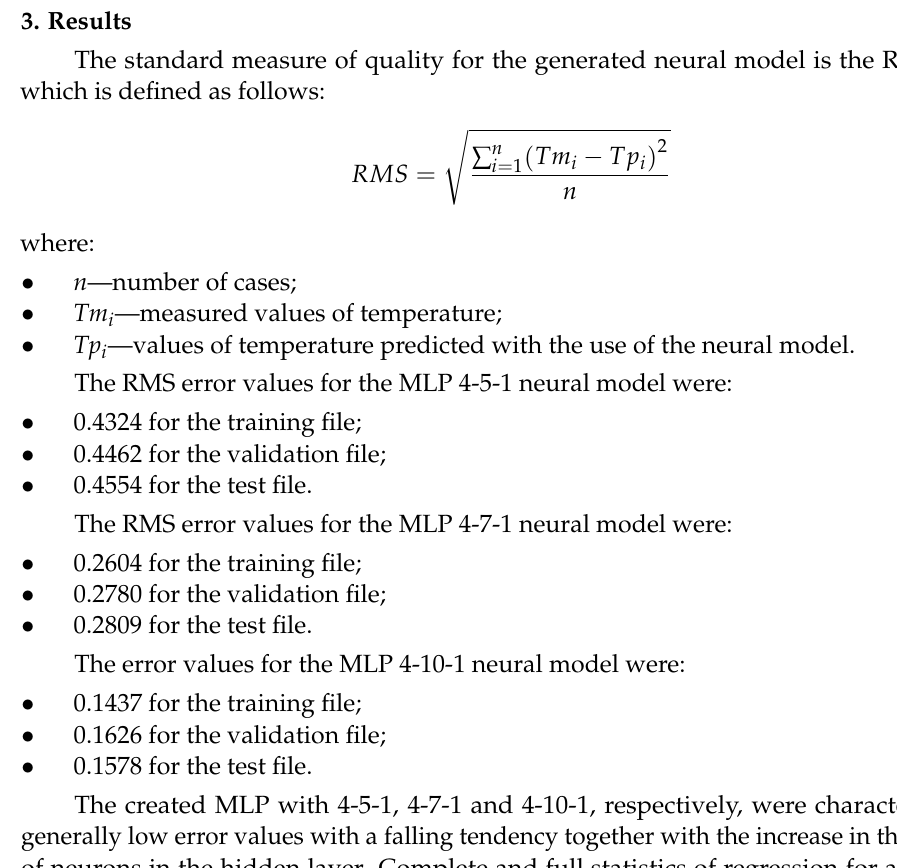
Figure 3. The structure of the model developed—MLP 4-7-1.